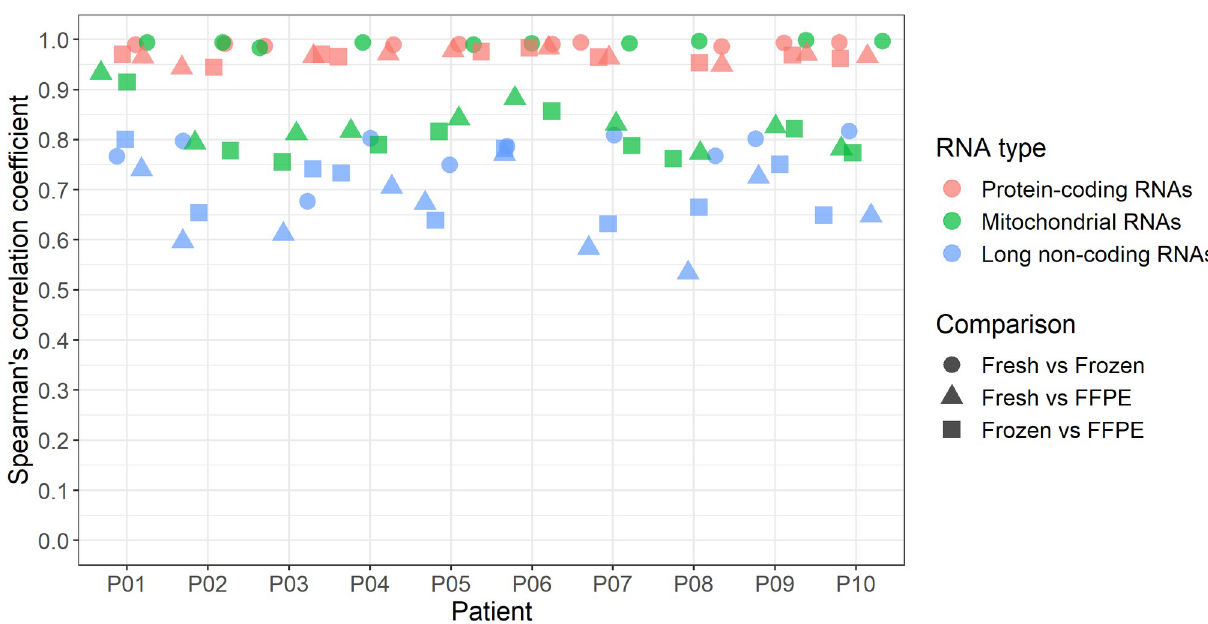
Fig 4. Spearman’s correlation coefficients of intra-individual gene expression levels from fresh, frozen, and formalin-fixed, paraffin-embedded (FFPE) tissue. Correlations were calculated for all 10 patients based on the protein-coding, mitochondrial, and long non-coding RNAs when comparing fresh, frozen, and FFPE